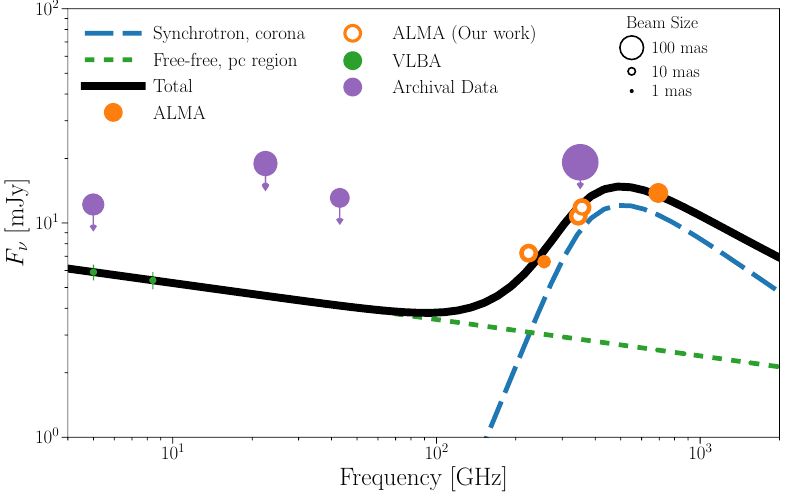
Figure 6. The cm–mm spectrum of NGC 1068. The data points from VLBA [83] and ALMA [84–86] are shown in green and orange, respectively. The open points represent the newly analyzed ALMA data. The size of circles corresponds to the beam sizes as indicated in the figure. We also show the archival mm–cm data having large beam sizes as upper limits in purple [12,87,88]. The error bars correspond to 1- σ uncertainties. The blue dashed and green dotted lines show the coronal synchrotron and pc-scale free–free components, respectively. The solid black line shows the sum of these two components. Taken from Inoue et al.